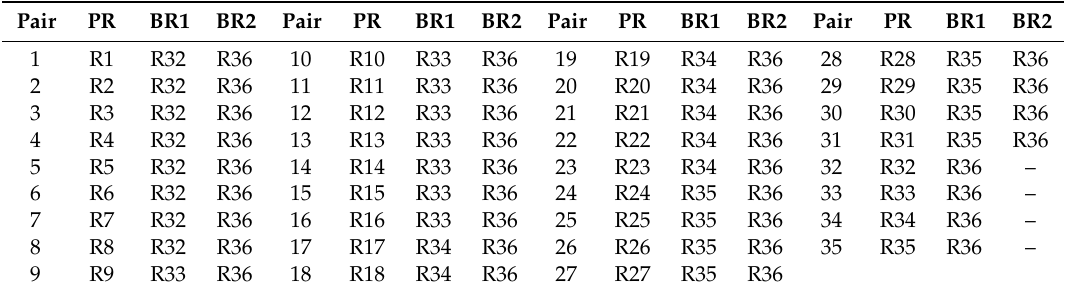
Figure 16. One-line diagram of the Jhimpir wind-farm-integrated substation. Table 8. Primary–backup relay pairs for the Jhimpir wind-farm-integrated substation.